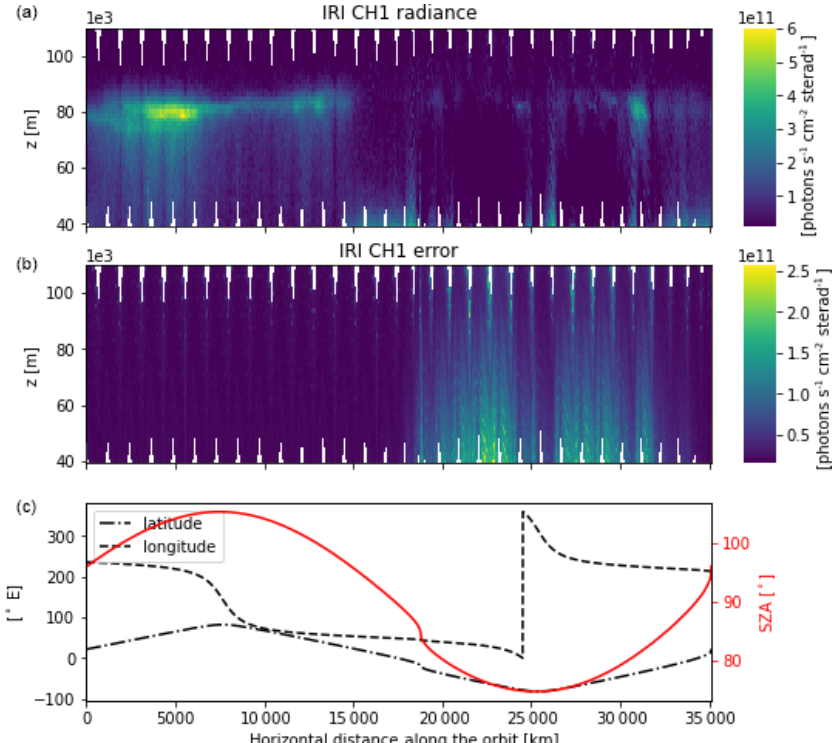
Figure 2. (a, b) An orbit of IRI channel 1 limb radiance and its error estimate respectively, recorded in orbit 10122. (c) Latitude (black dot-dashed line) and longitude (black dashed line) coordinate of the image represented tangent point as well as the solar zenith angle (SZA) at that location (red solid